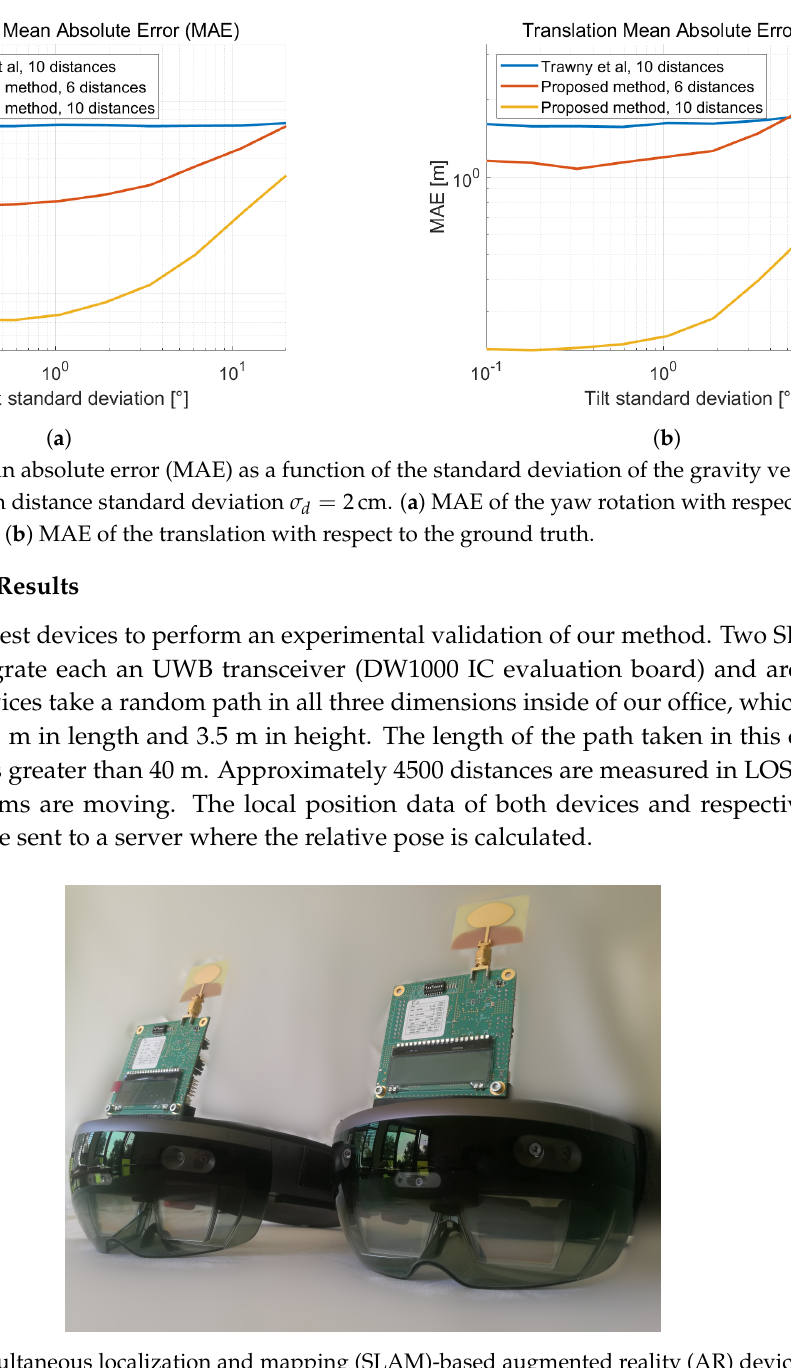
Figure 9. Simultaneous localization and mapping (SLAM)-based augmented reality (AR) devices with integrated ultra-wideband (UWB)